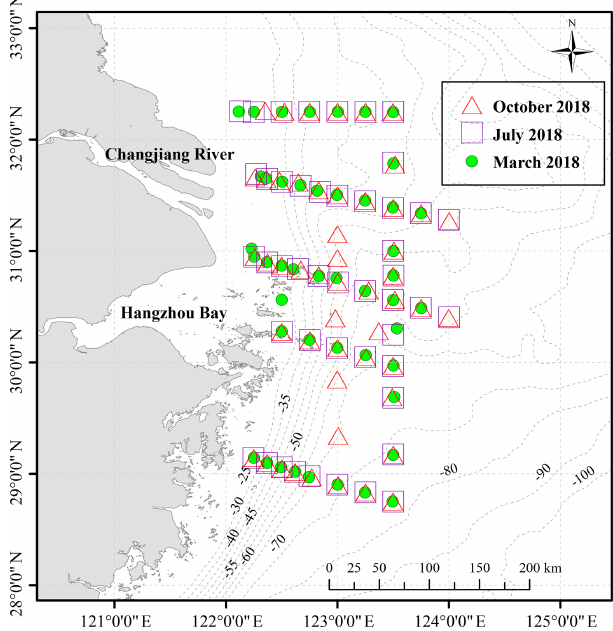
Figure 1. Sampling stations during 11 cruises (the confirmatory dataset) from 2013 to 2017 on the East China Sea shelf. Figure 2. Sampling stations for three cruises (the exploratory dataset) used to extend the utility of the ANN model. The green cir- cles represent March 2018, the purple squares represent July 2018 and the red triangles represent October